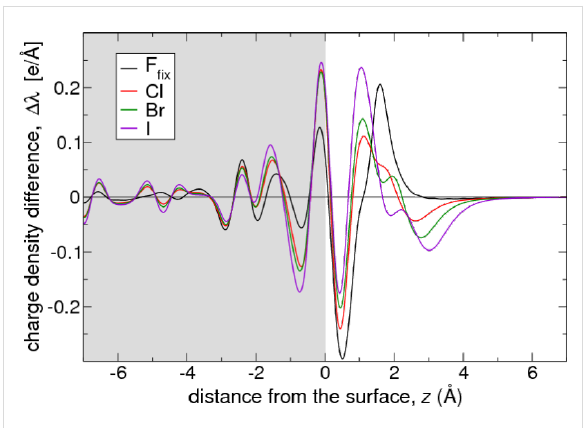
Figure 3: Charge density difference Δλ ( z ) for the adsorption of fluo- rine, chlorine, bromine, and iodine on Pt(111) at the fcc hollow pos- ition for a coverage of 1/16 ML. The subsurface region corresponds to the gray-shaded area at z <